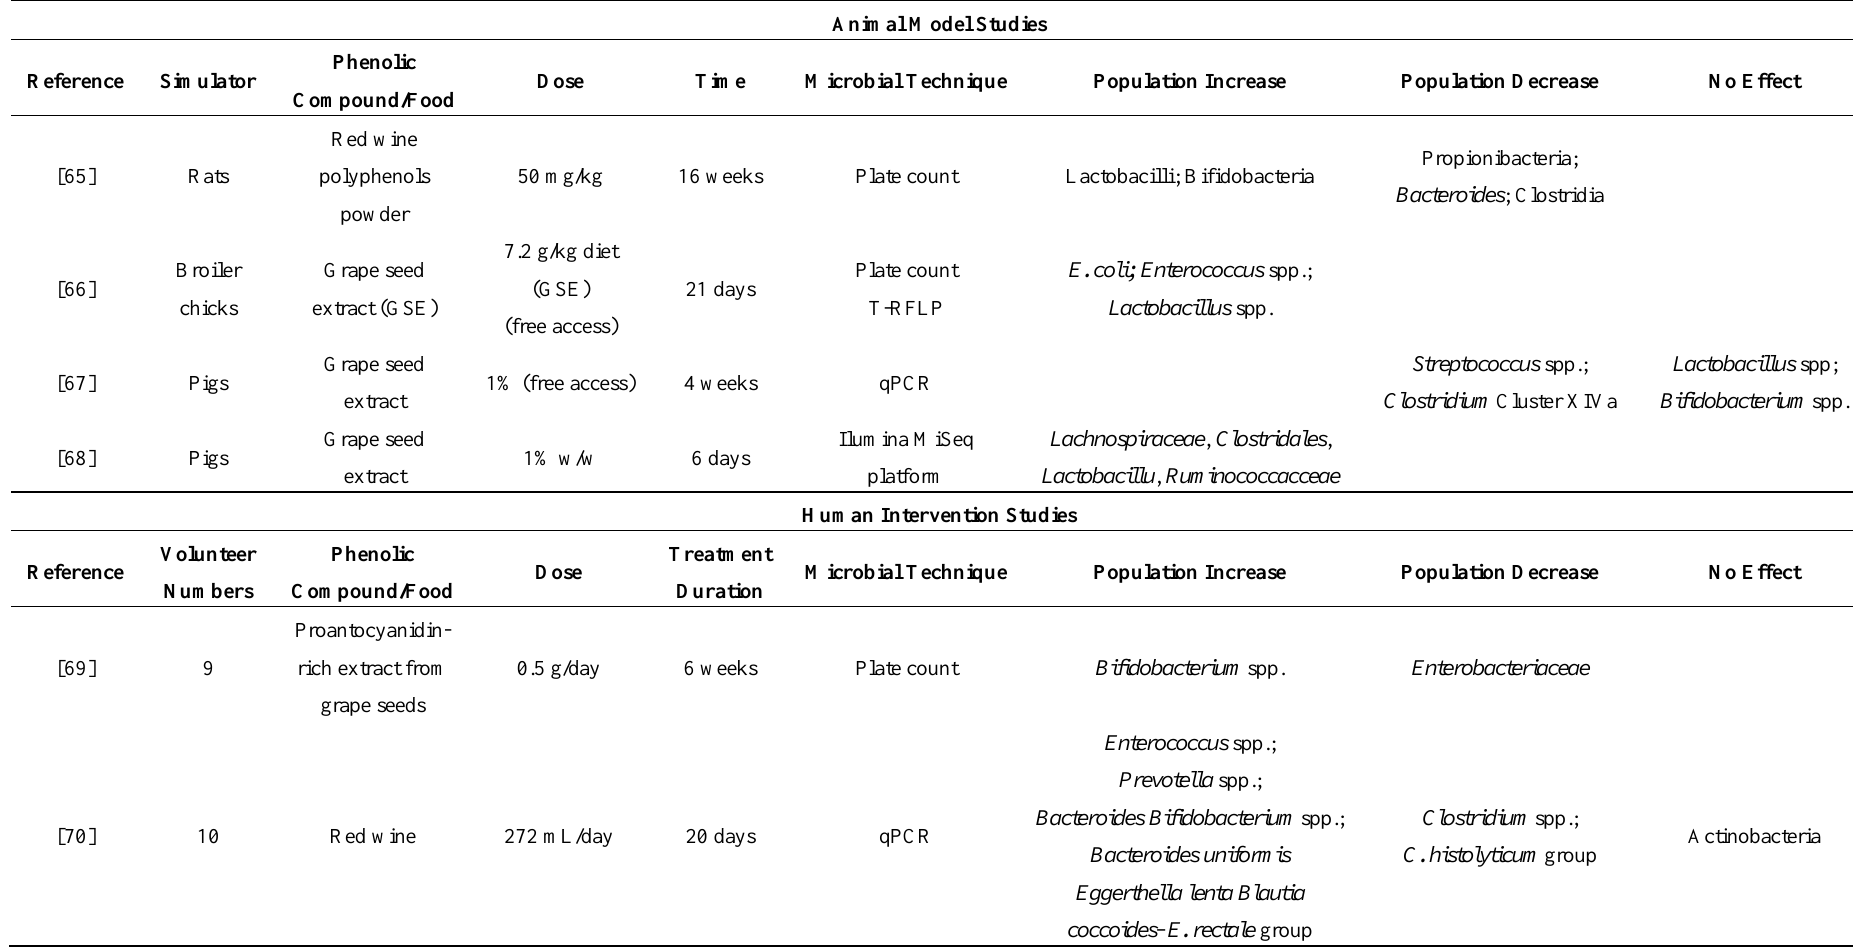
Table 2. Studies regarding modulation of gut microbiota by wine polyphenols in studies with animals and